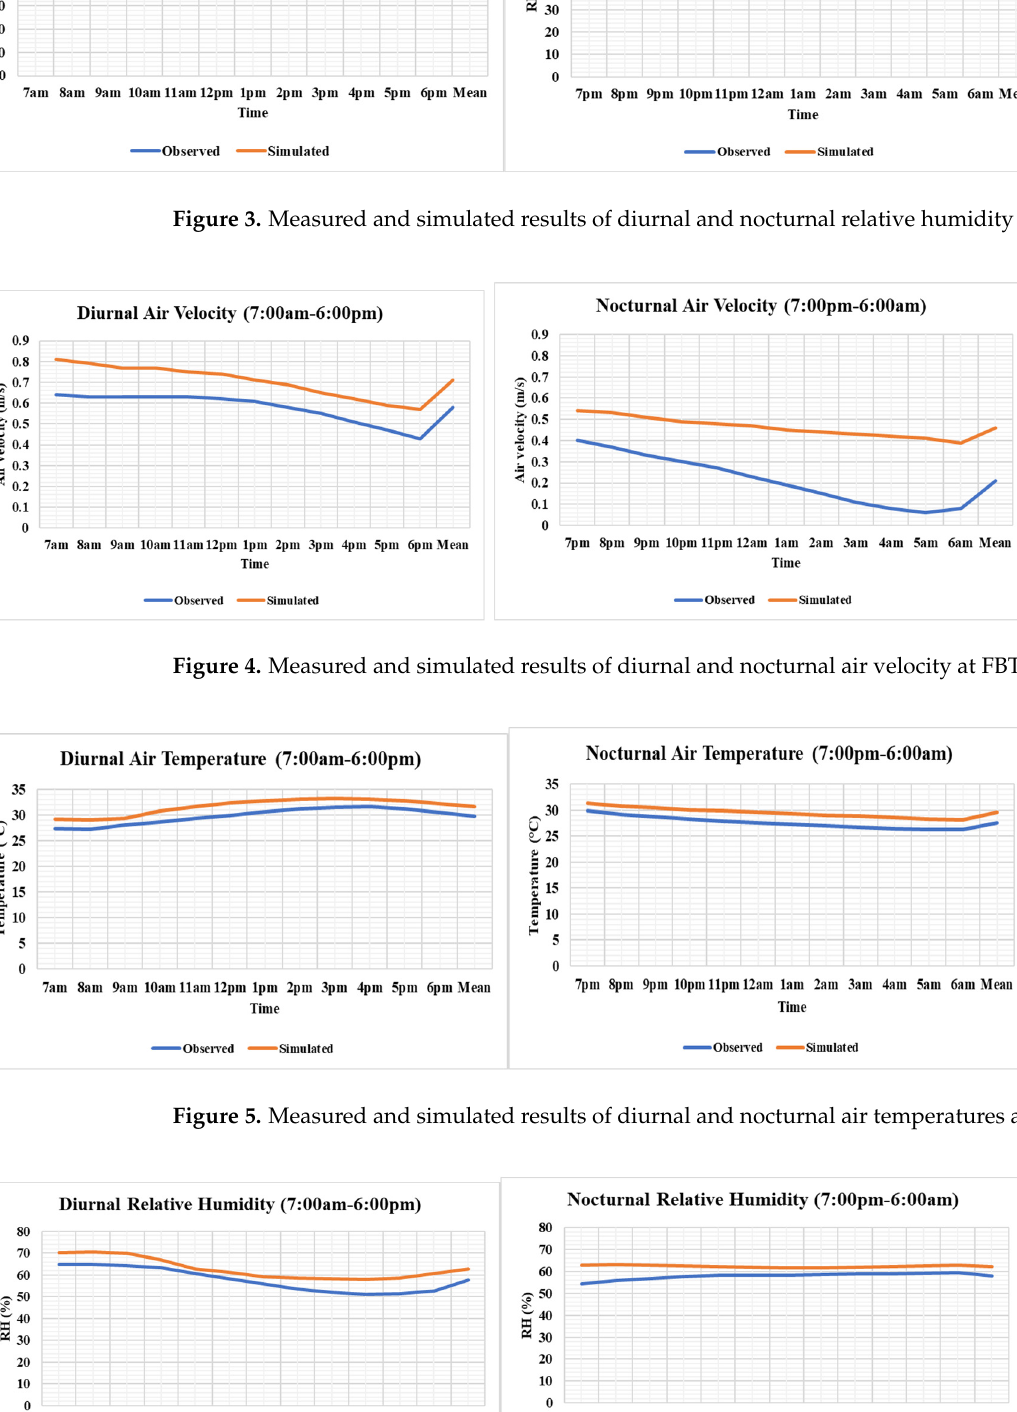
Figure 5. Measured and simulated results of diurnal and nocturnal air temperatures at SM.